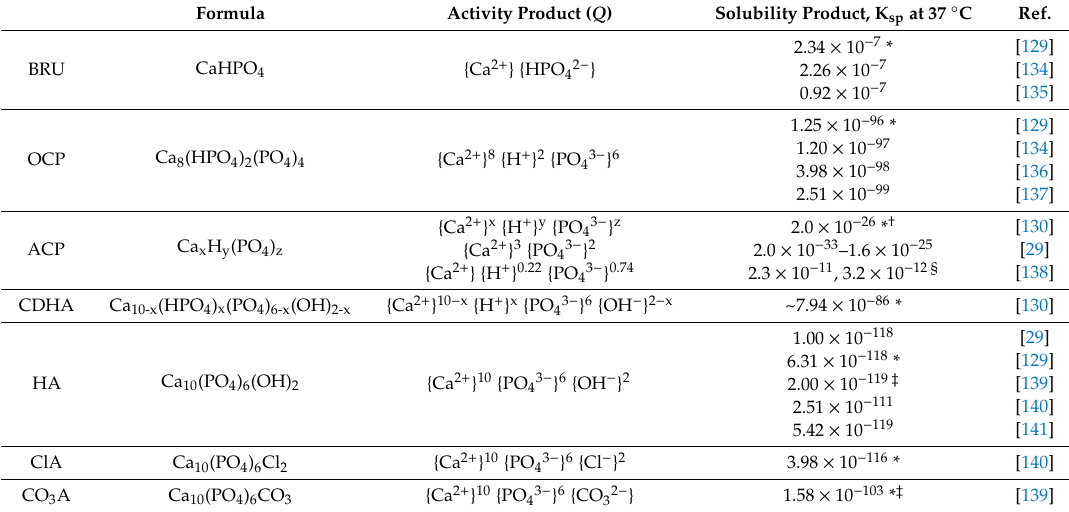
Table 4. The precipitation of insoluble calcium orthophosphates. The activity products ( Q ) and the solubility products K sp (at 37 ◦ C) are obtained from the